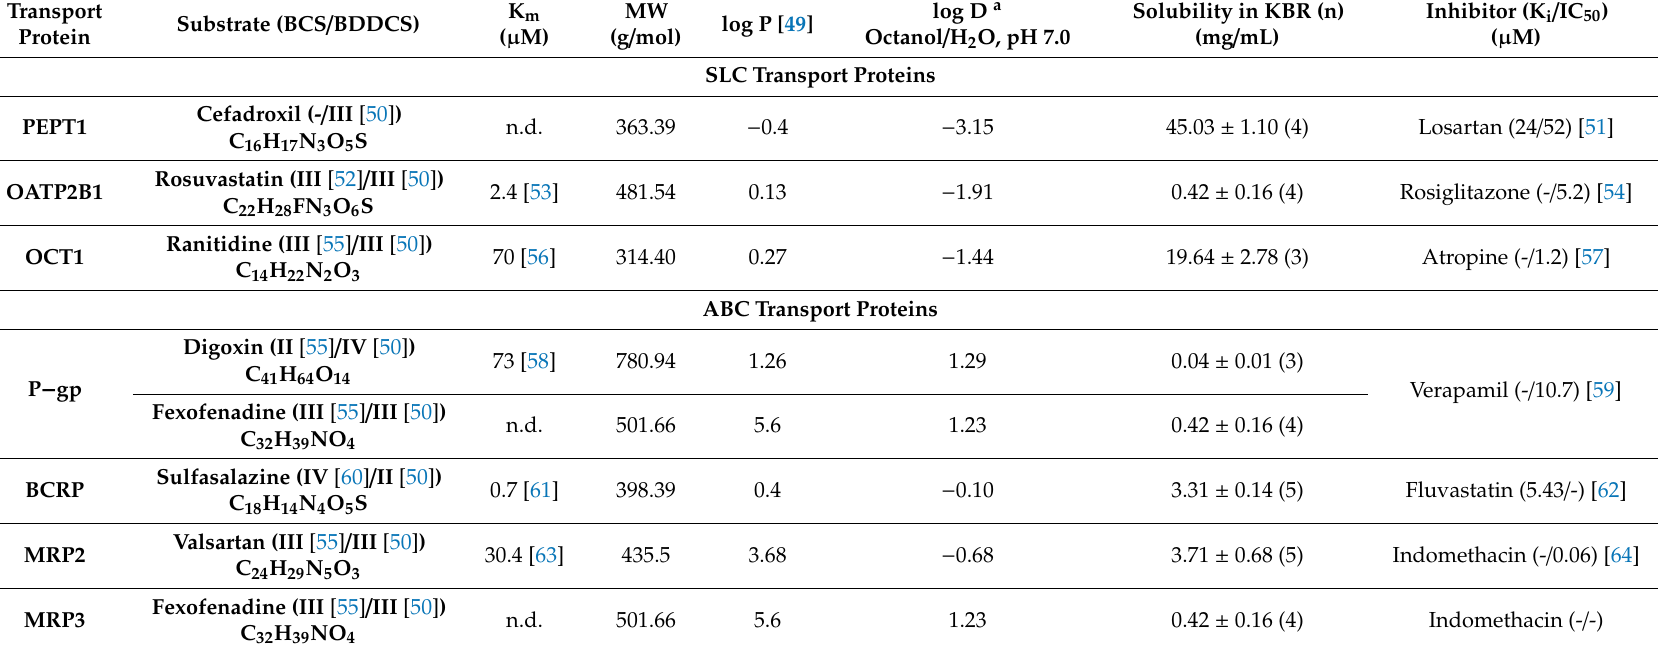
Table 1. Physicochemical properties of the drug molecules used to investigate the presence and activity of membrane transport proteins in porcine intestine using the Ussing chamber system ( n = number of